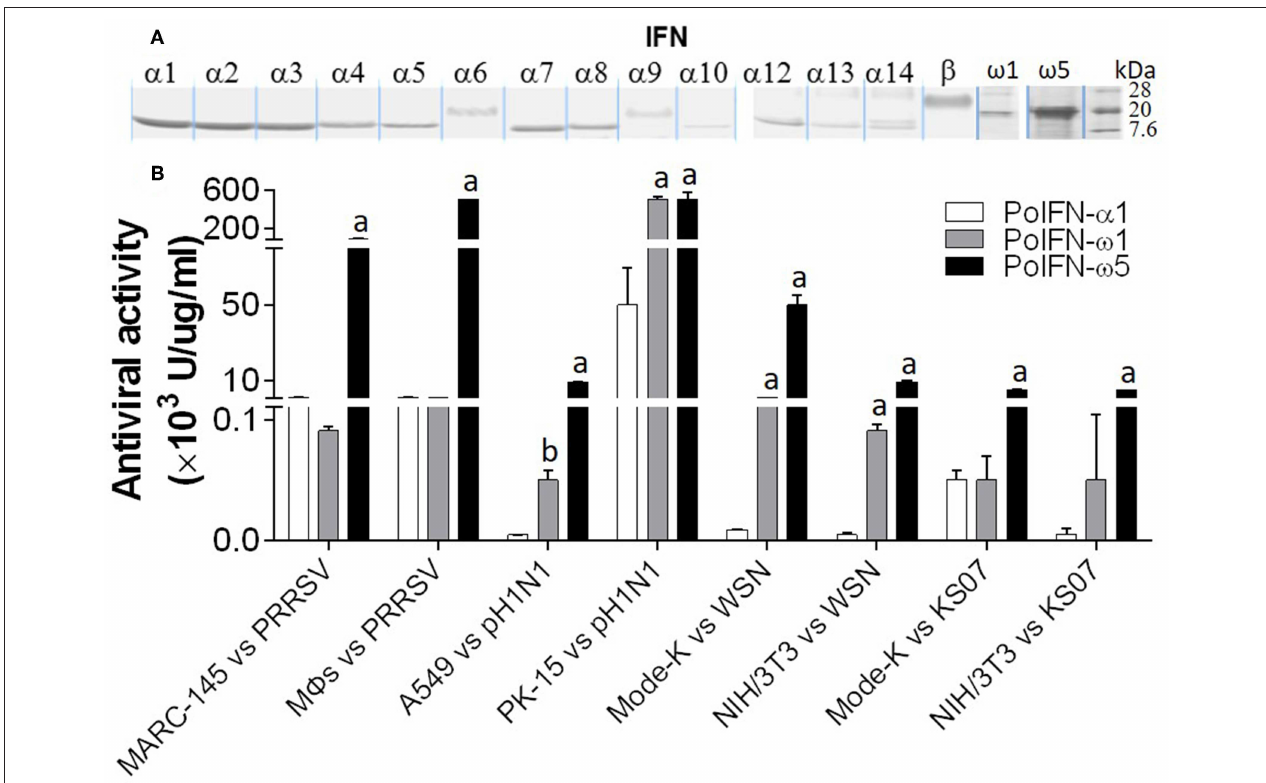
FIGURE 9 | Porcine IFN- ω peptides exert broad and high antiviral activity in porcine, monkey, human, and mouse cells. (A) A series of porcine IFN peptides were overexpressed using a mammalian cell expression system (HEK193F, Invitrogen, Carlsbad, CA). IFN peptides were collected and partially purified using two Centricon ® centrifugal filters (10 and 50k NMWL, Millipore, Billerica, MA). Concentrated IFN-peptides were subjected to gel electrophoresis and stained with a bio-safe Coomassie Blue G-250 solution. Shown are peptide bands of most IFN- α / β subtypes, IFN- ω 1, and IFN- ω 5. Note that the bands of IFN- α 6, IFN- α 9, and IFN- β are smeared and have apparent molecular weights higher than expected values ( ∼ 20 kDa), which might reflect posttranslational modification such as N-glycosylation ( 13, 23). (B) Porcine IFN- ω peptides exert broad and high antiviral activity against PRRSV and influenza A virus in cells from pigs, monkeys, humans, and mice. The antiviral activity of IFN peptides was titrated as described (7), except viruses were quantified using fluorescence-labeling (PRRSV-DsRed and FITC-immunostaining for influenza A nucleoprotein) in the susceptible cells of monkey MARC-145, porcine macrophages (M Φ s) and PK-15, human A549, and mouse Mode-K and NIH3T3 (13, 24). A PRRSV-P129 strain, and three influenza strains, pH1N1, WSN, and KS07 were used. a,b; p < 0.001, 0.01 to IFN- α 1, respectively. Data are means ± SE; n =